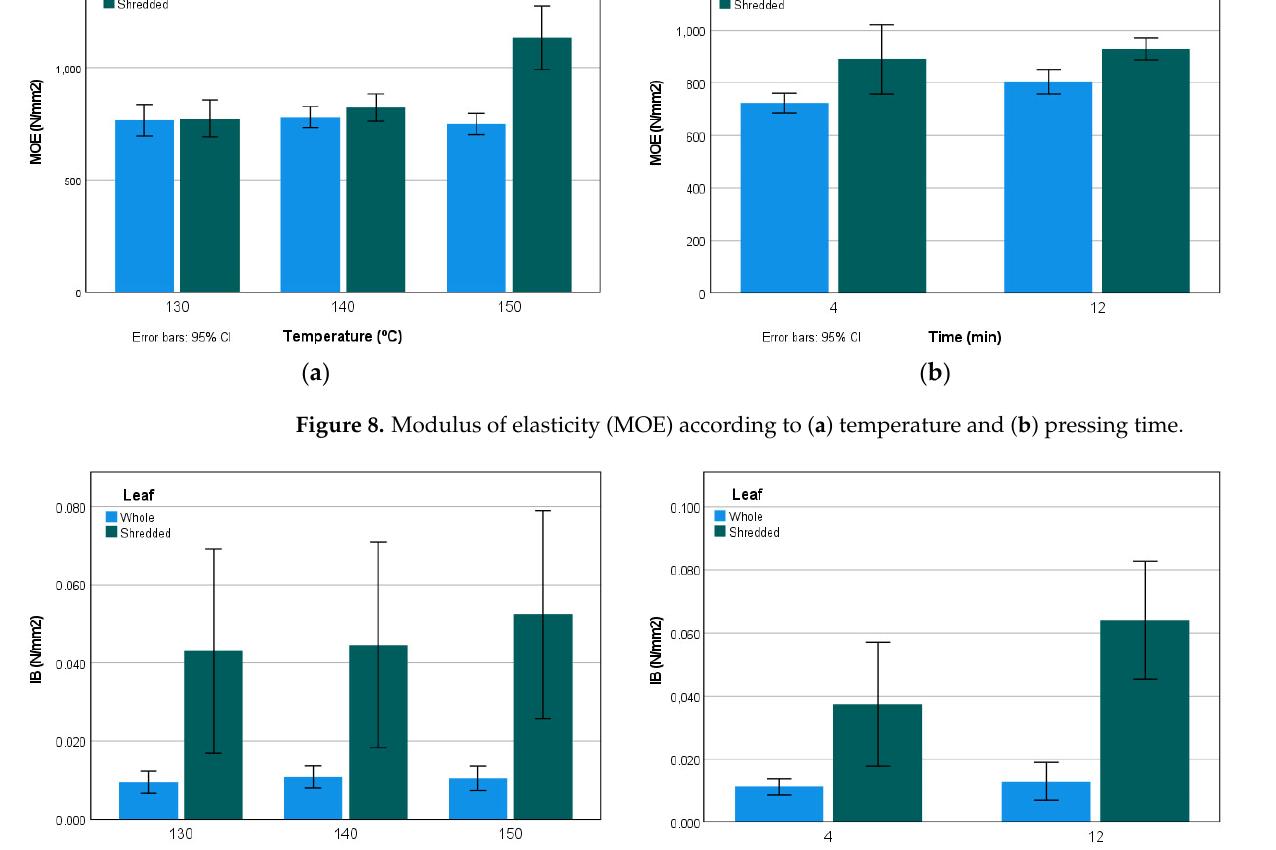
Figure 10. Thermal conductivity according to ( a ) temperature and ( b ) pressing time.